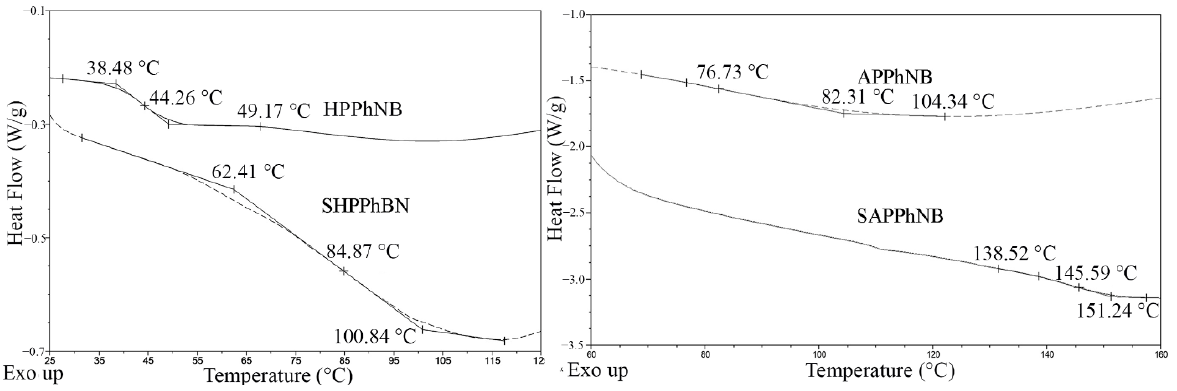
Figure 1. DSC curves of sulfonated (bottom) and initial polymer